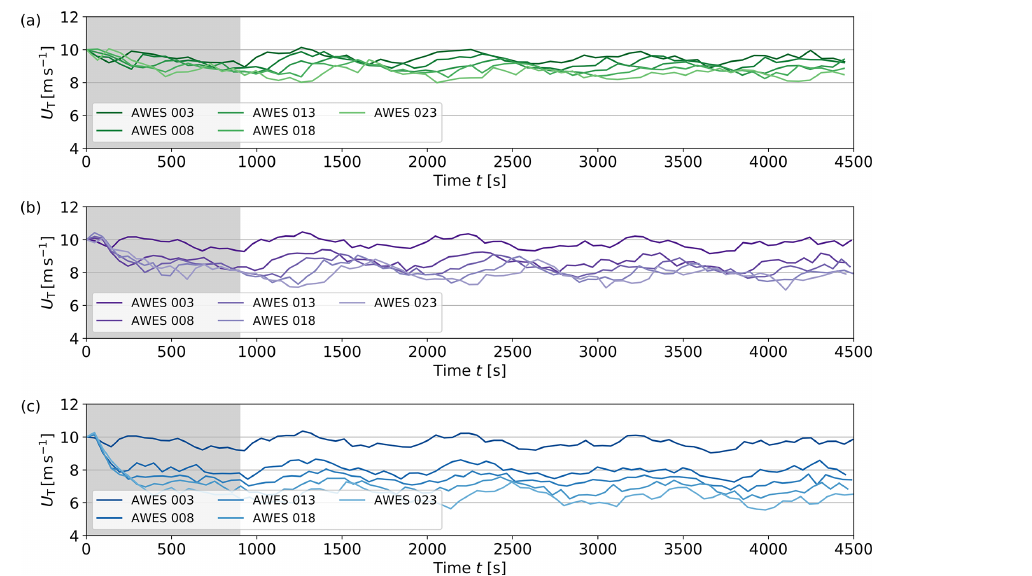
Figure 15. Time series of reference wind speed tracked by the five AWE systems of the central park column ( x = 2000m) for the AWE parks L1 (a) , D1 (b) , and D2 (c) . The grey shaded area covers the spin-up phase of the park